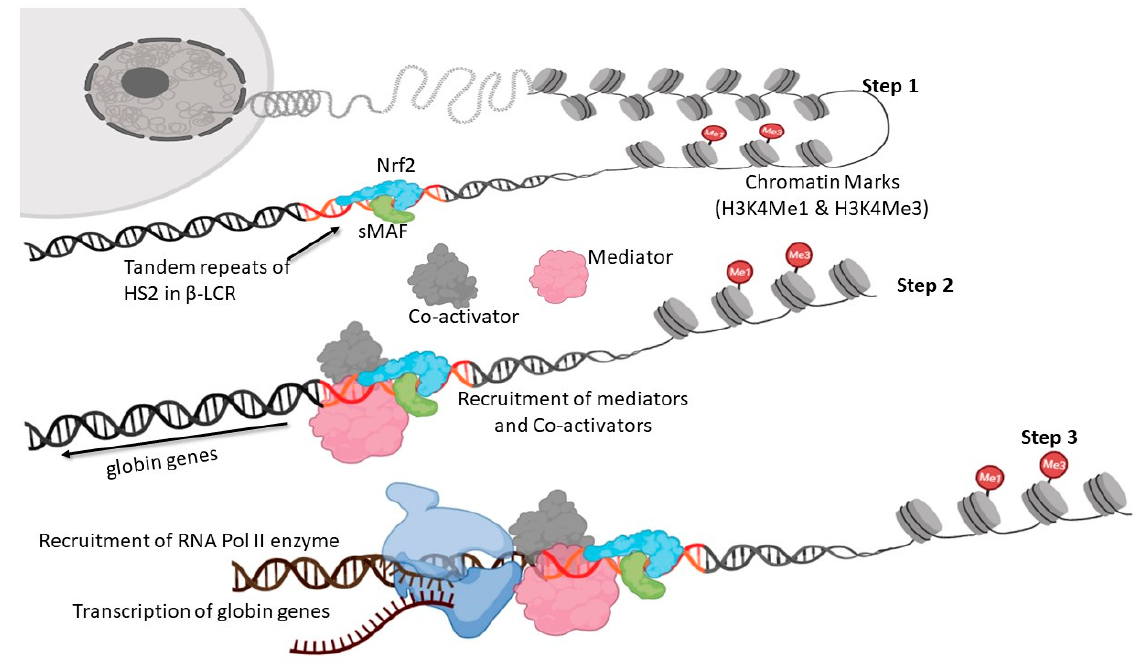
Figure 3. Illustrations show stepwise deciphering of how the heterodimer of Nrf2-sMAF in the nu- cleus mediates the transcription of globin genes accordingly, after binding at the regulatory se- quence of the gene. For globin gene expression, heterodimer of Nrf2 with sMAF binds to the tandem repeats of hypersensitive site 2 (HS2) in β -LCR ( β -locus control region). This heterodimer of Nrf2 with sMAF recruits coactivators and mediators to the site and makes the chromatin structure acces- sible to the RNA polymerase II (Pol II) enzyme. Thereafter, Pol II and general transcription factors (not shown in the illustration) are recruited to transcribe the globin genes. factors (not shown in the illustration) are recruited to transcribe the globin